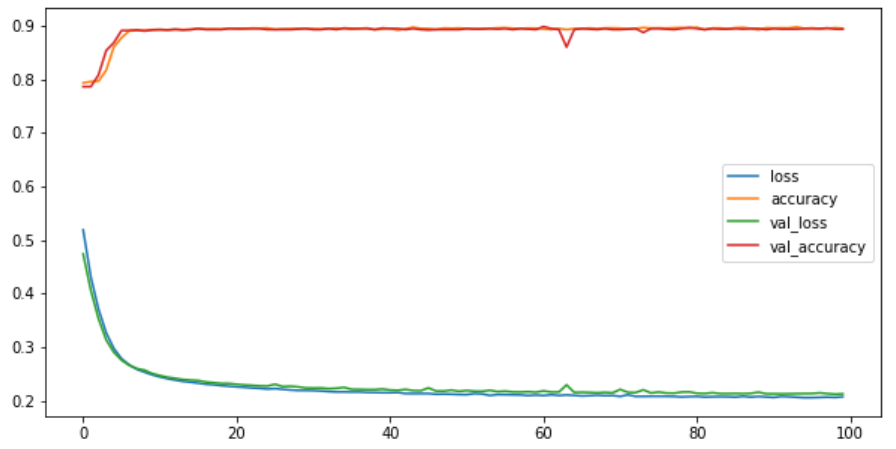
Figure 2. Training and Validation loss vs. Training and Validation